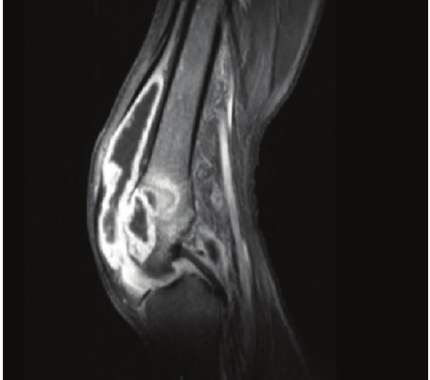
Figure 4: Abscesses around the left knee